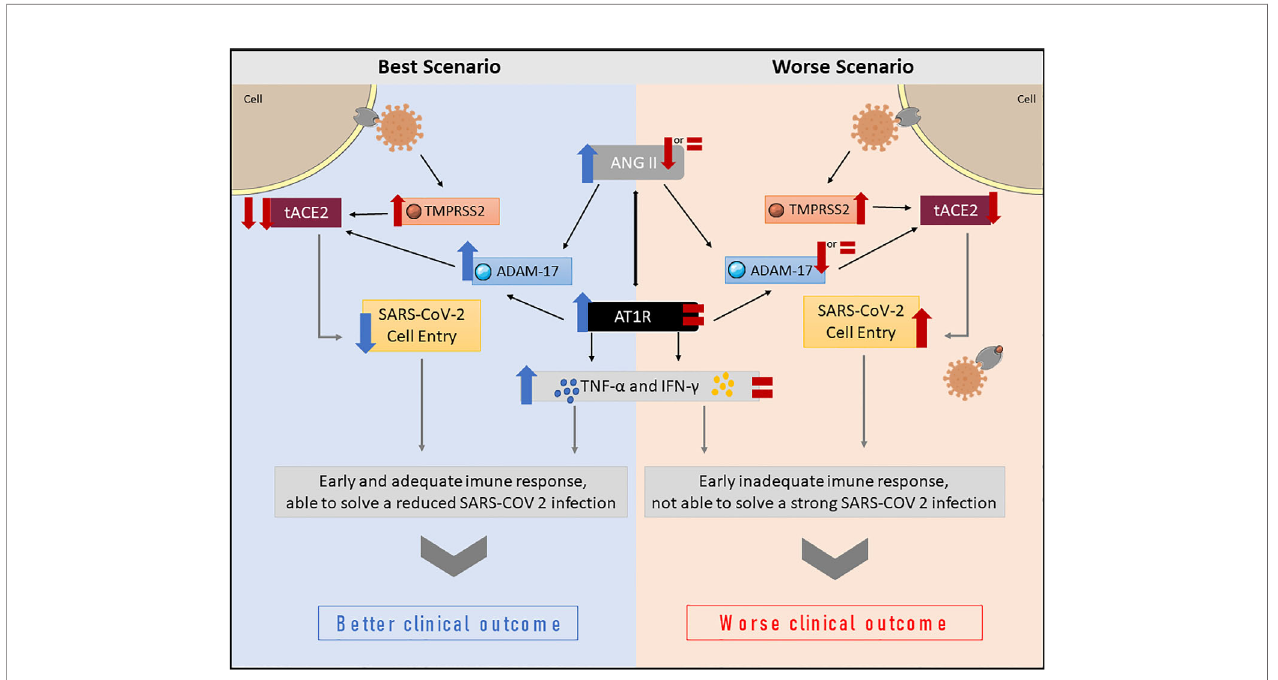
FIGURE 2 | Summary of proposed changes in the RAAS, and downstream effects following SARS-CoV-2 infection. In the best-case scenario, a peak of ANG II occurs immediately after SARS-CoV-2 infects the cell. The virus reduces tACE2 levels due to increased TMPRSS2 and ADAM-17 activity. Reduced tACE2 levels decrease virus entry into the cell, and, consequently, the viral load. The ANG II peak will also increase AT1R activation, modulating not only the ANG II effects, but also the host immune response, which produces TNF- a and IFN- g in an appropriate time and amount, favoring better clinical outcomes. In the worst-case scenario, the host is unable to elevate ANG II levels. Even with reduced tACE2 due to virus TMPRSS2 activation, ANG II levels remain unaltered or reduced. Consequently, ADAM-17 activation is lower or unaltered, thus, more tACE2 is available, allowing more virus to enter the cell and replicate. Moreover, AT1R activation is also low or unaltered, which leads to an inappropriate early immune response, favoring poor clinical